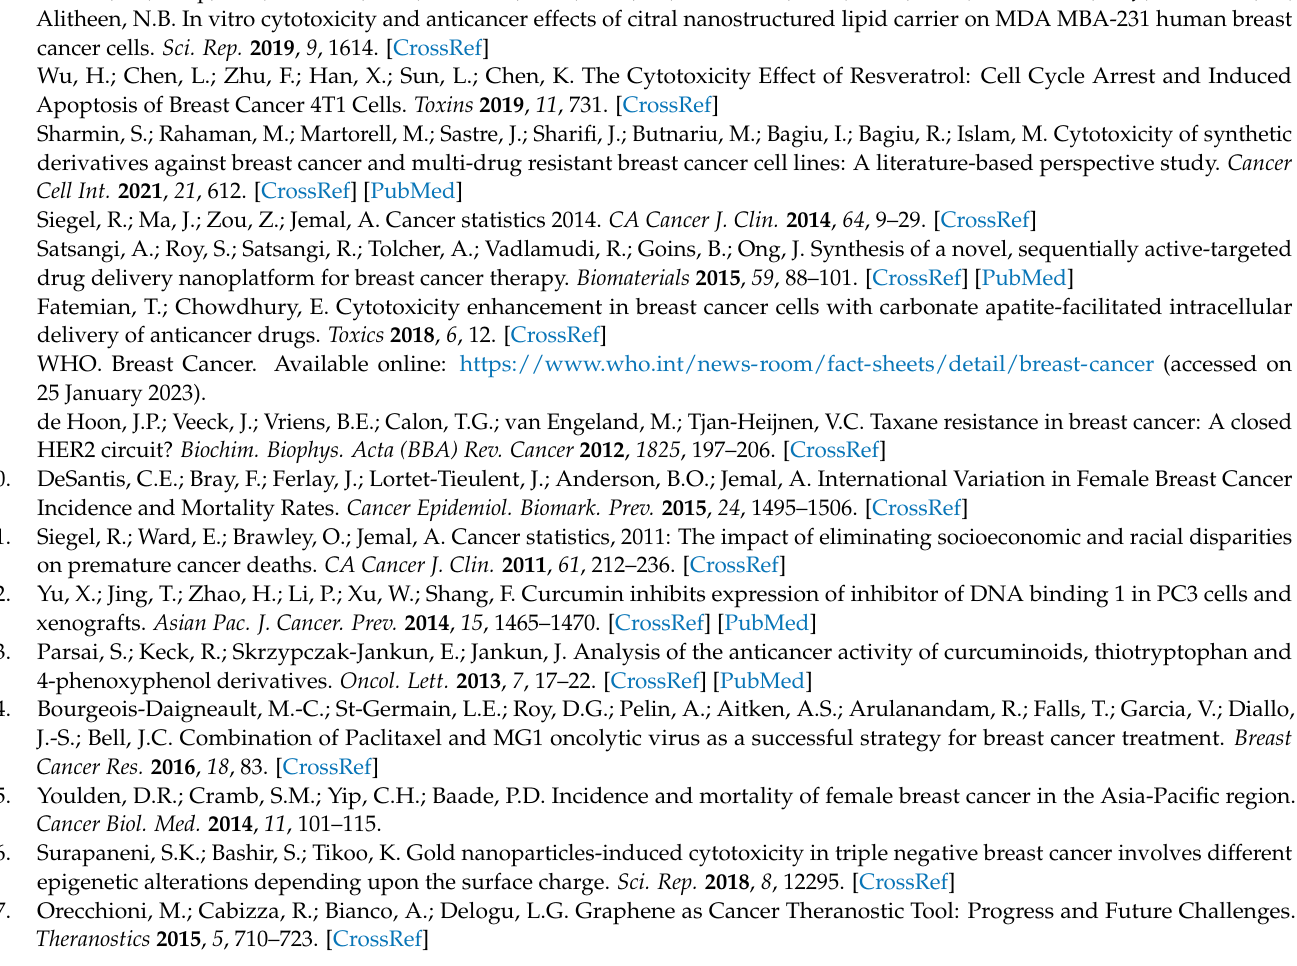
Table S4: the cytotoxicity of GR-HAP on SUM-159